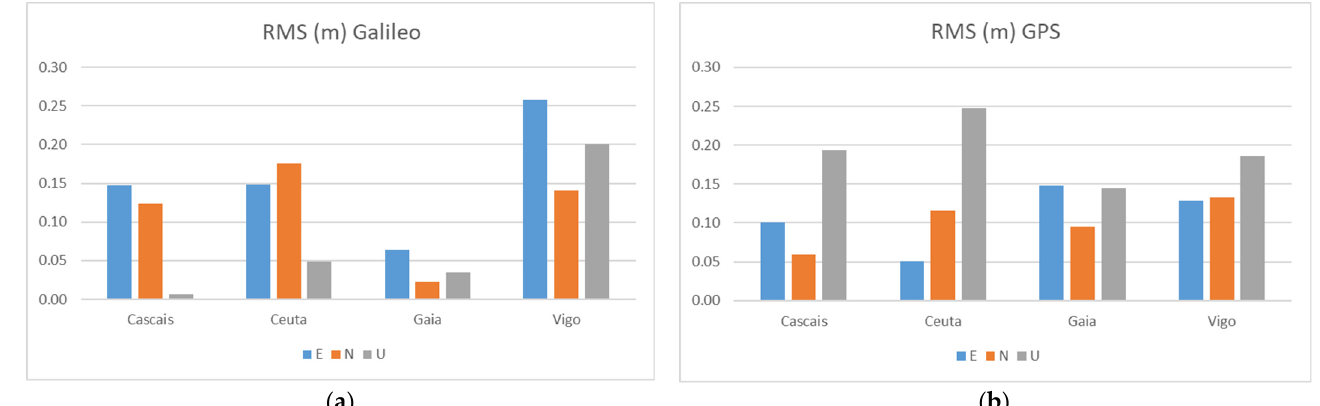
Figure 13. RMS results for the Galileo-only ( a ) and GPS-only ( b ) solutions at Test 1.